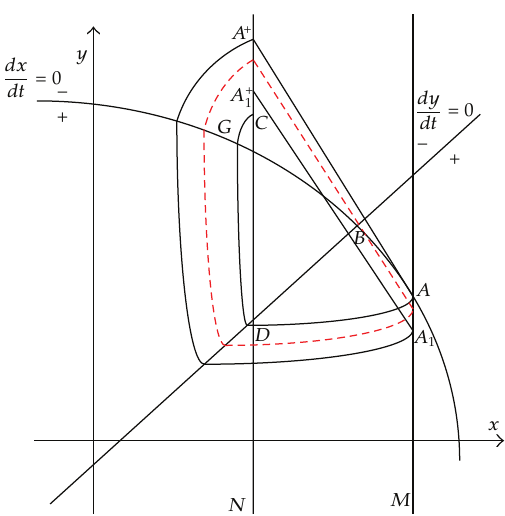
Figure 5: Illustration of system (cid:6) 1.3 (cid:7) for the case h > x ∗ , (cid:6) 1 − p (cid:7) h < x ∗ , x G < (cid:6) 1 − p (cid:7) h , y A (cid:9) > y C